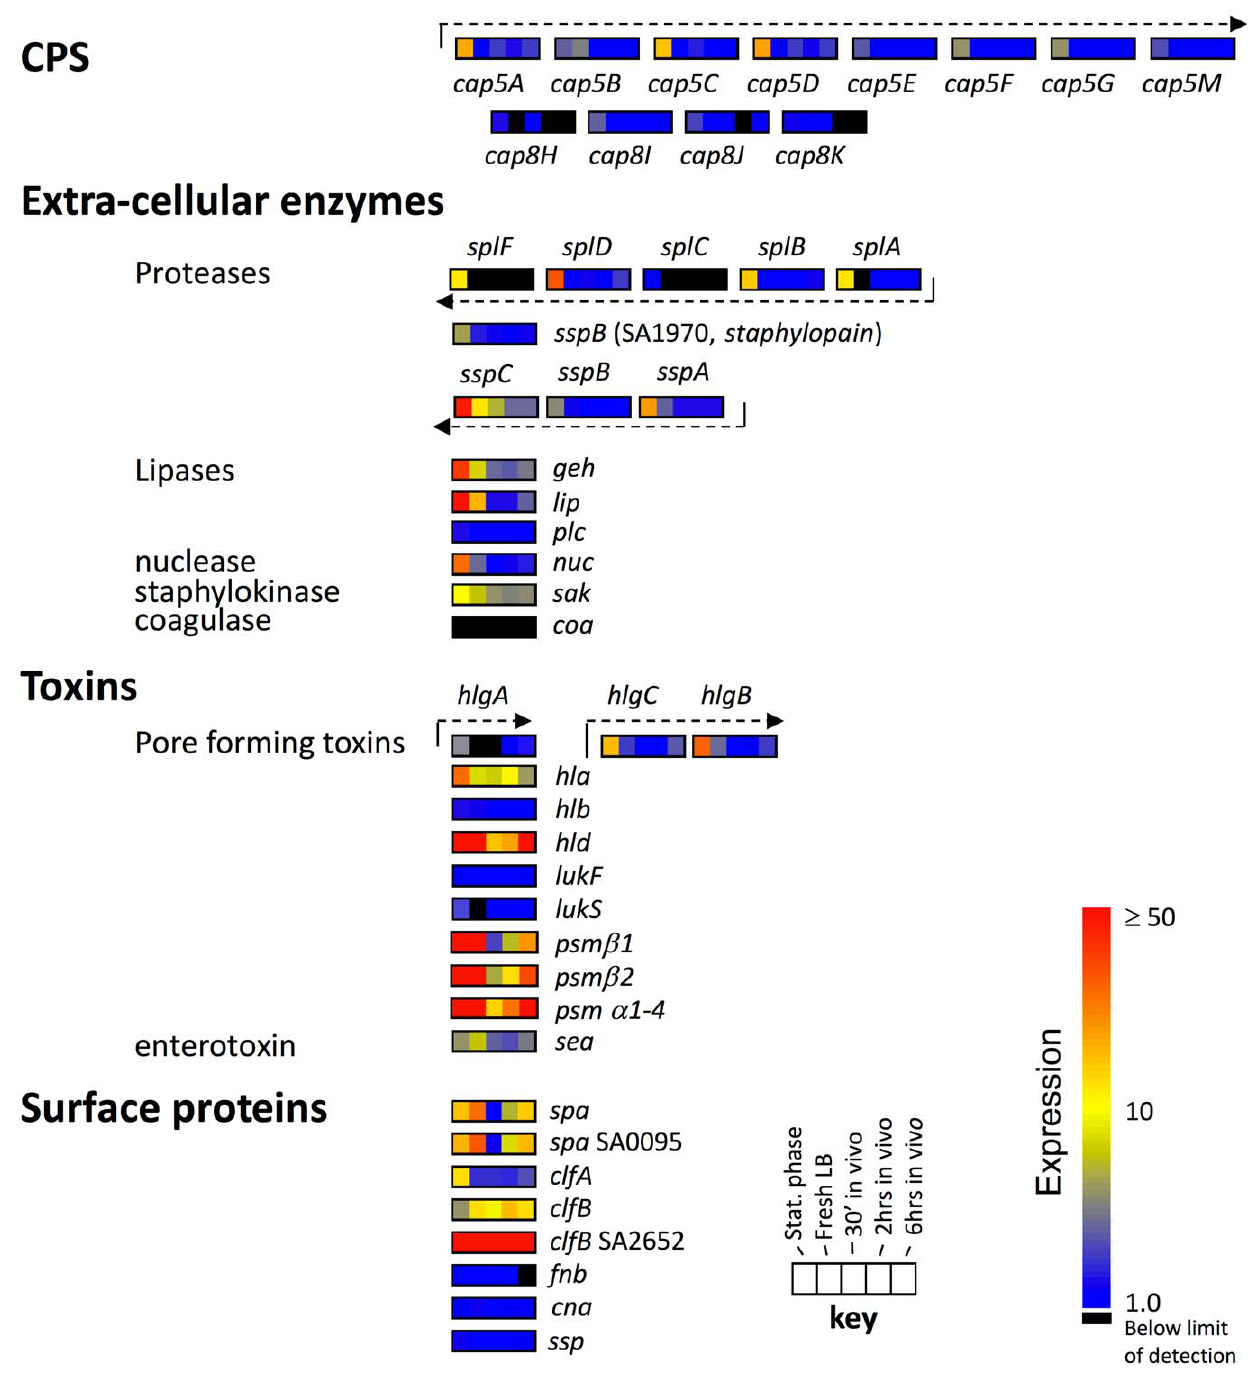
Figure 9. Expression of S.aureus virulence factors in strain JP1 during growth in laboratory media and the mouse airway. The color scale on the right indicates transcriptional activity for each gene and corresponds to the key for growth conditions at the bottom right of the figure. Transcriptional units are shown as dashed lines above their respective operons. doi:10.1371/journal.pone.0041329.g009 and gpxA and general stress proteins 20 U ( dps ) and universal stress